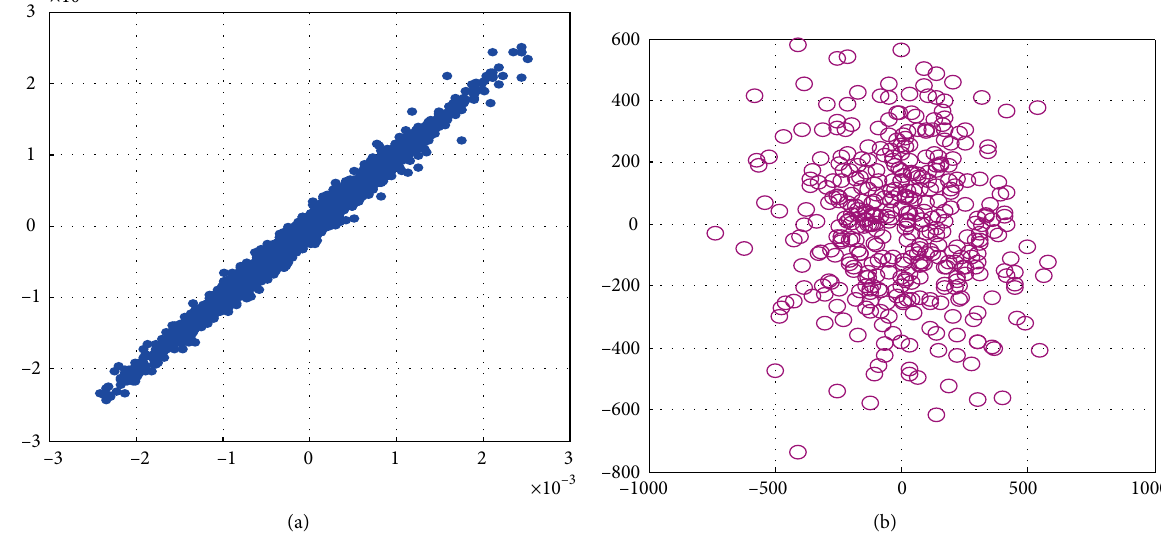
Figure 4: Scatter plot diagram of (a) original speech signal (b) encrypted speech signal.